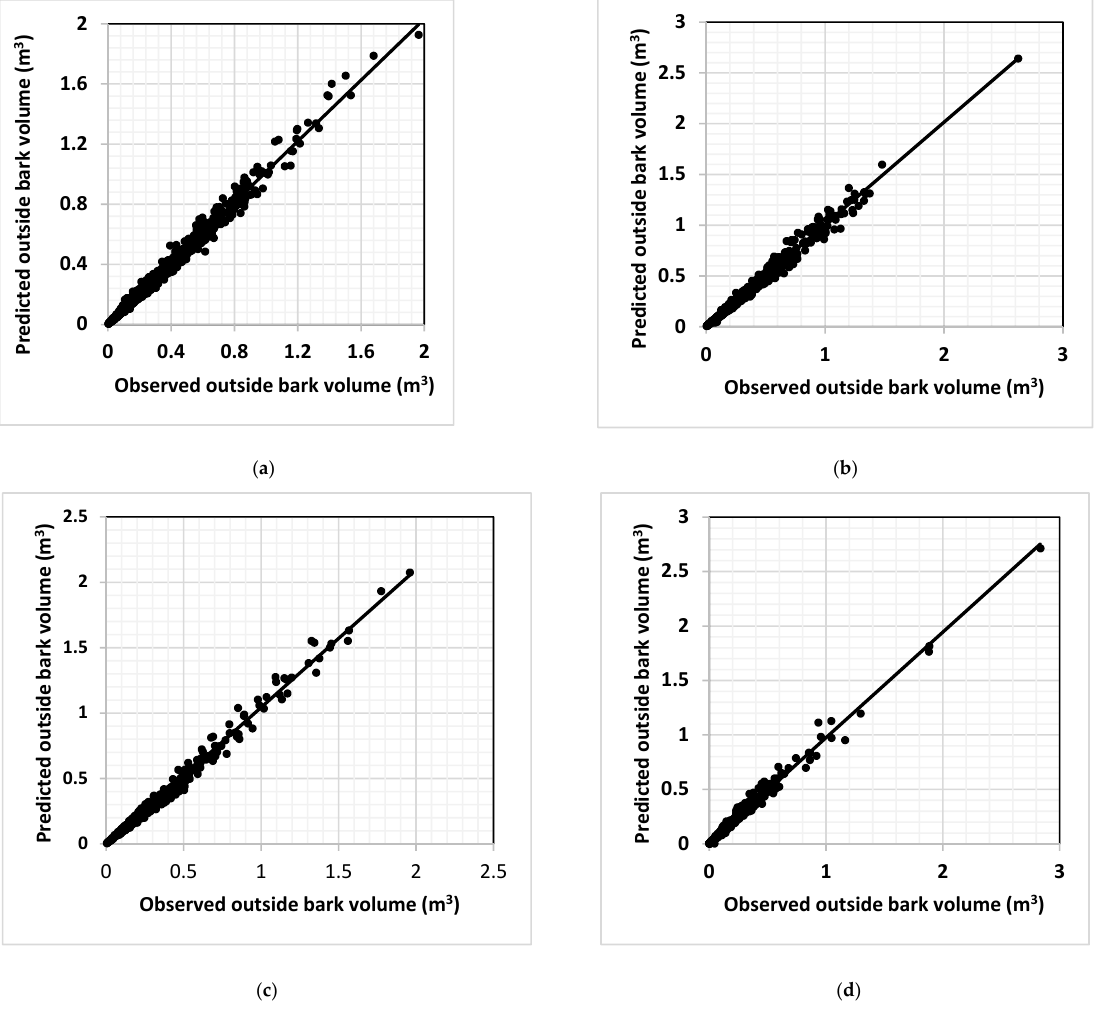
Figure 3. Predicted outside bark volumes plotted against observed volumes for ( a ) jack pine, ( b ) black spruce, ( c ) balsam fir, and ( d ) sugar maple trees. The solid line represents the 1:1 line for these tree species. As mentioned, accuracy of Equation (10) was verified by comparing bias, absolute bias, and RMSE in estimating inside bark volumes that resulted from this equation with